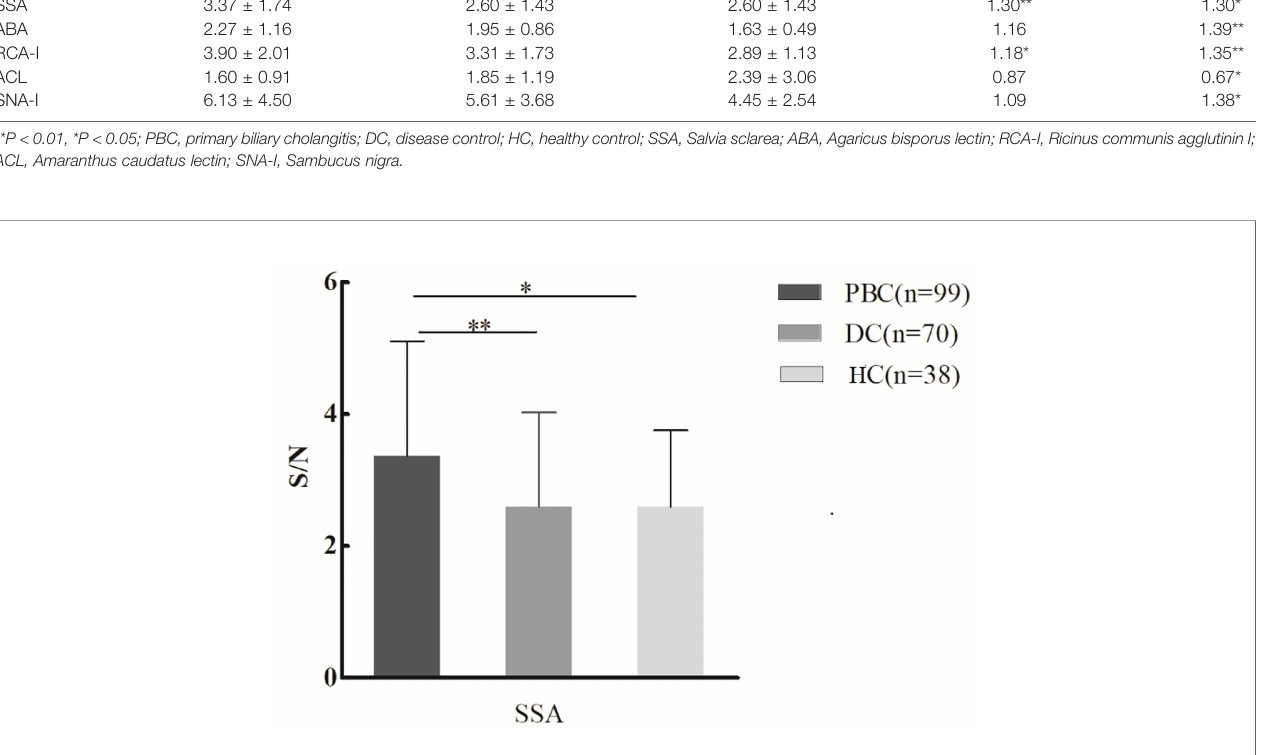
FIGURE 1 | Speci fi c changes of serum IgG glycosylation in PBC patients ’ comparison with DCs and HCs from the lectin microarray. * P < 0.05. PBC, primary biliary cholangitis; DC, disease control; HC, healthy controls; SSA, Salvia sclarea . S/N, the medium intensity of the spot foreground relative to the background. **p < 0.01.